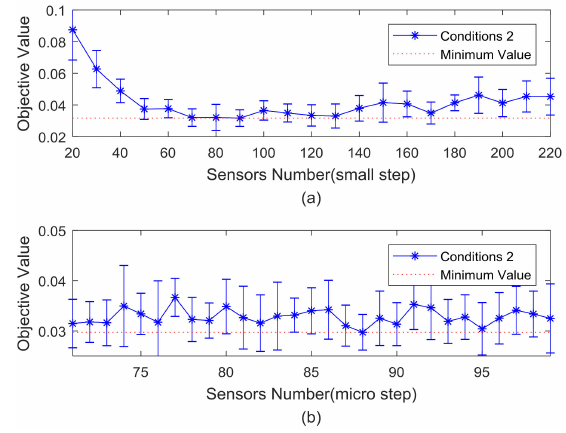
Figure 8. The curve of objective function value in Conditions 2. ( a ) sensors number between 20 and 220; and( b ) sensors number between 71 and